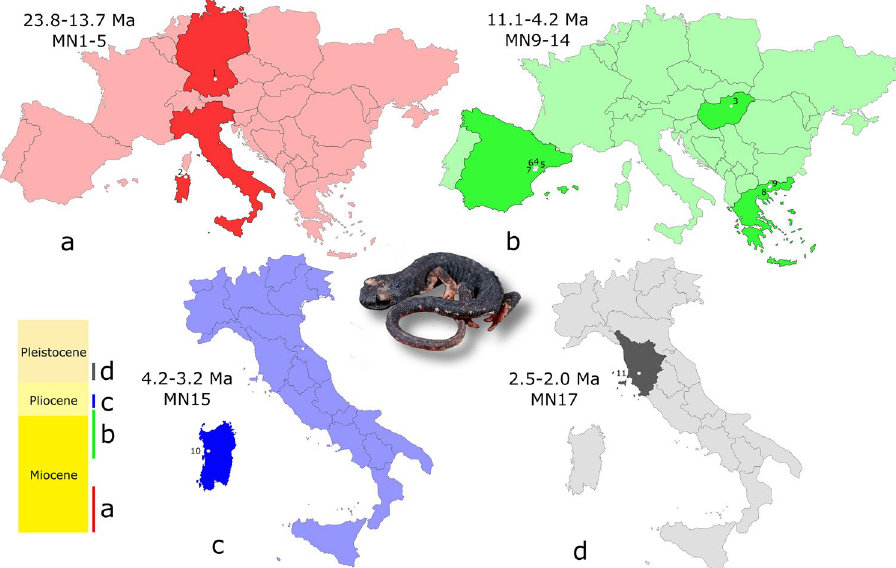
Figure 1. Time line of fossil localities yielding remains attributed to Salamandrina sp. (data from Macaluso et al . 13 ) from early Miocene ( a ) and late Miocene to early Pliocene ( b ) of Europe, and from Pliocene ( c ) and Pleistocene ( d ) of Italy. Information about the age in the left above corner of each map. “MN” refers to Mammal Neogene Units (see Agustí et al. 16 for the definition of the units). 1—Petersbuch, Germany (MN 4); 2—Oschiri, Italy (MN 1–5); 3—Felsötárkány Basin, Hungary (MN 9); 4—La Gloria 11, Spain (MN 10); 5—La Roma 1 and 2, Spain (MN 10); 6—Masada Ruea 2, Spain (MN 11); 7—Puente Minero 3, Spain (MN 11); 8—Ano Metochi